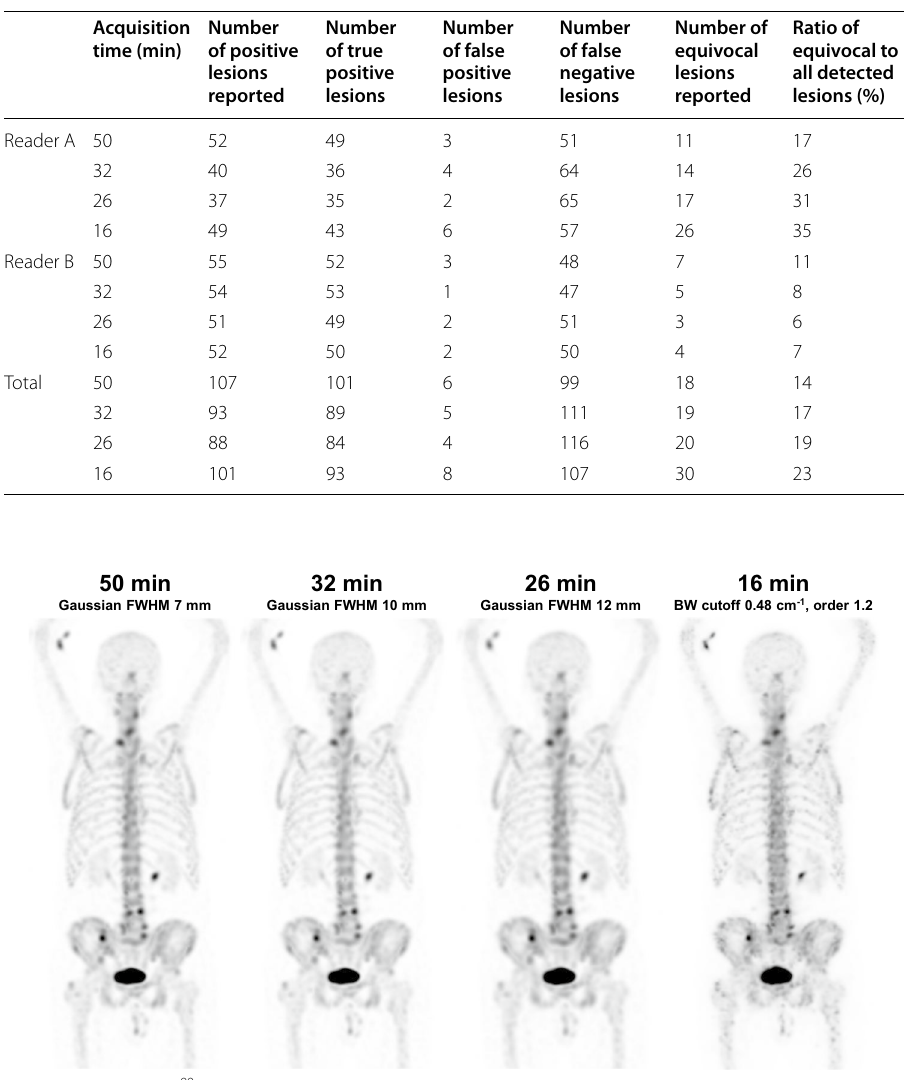
Table 5 Lesion-level analysis with decreasing acquisition time